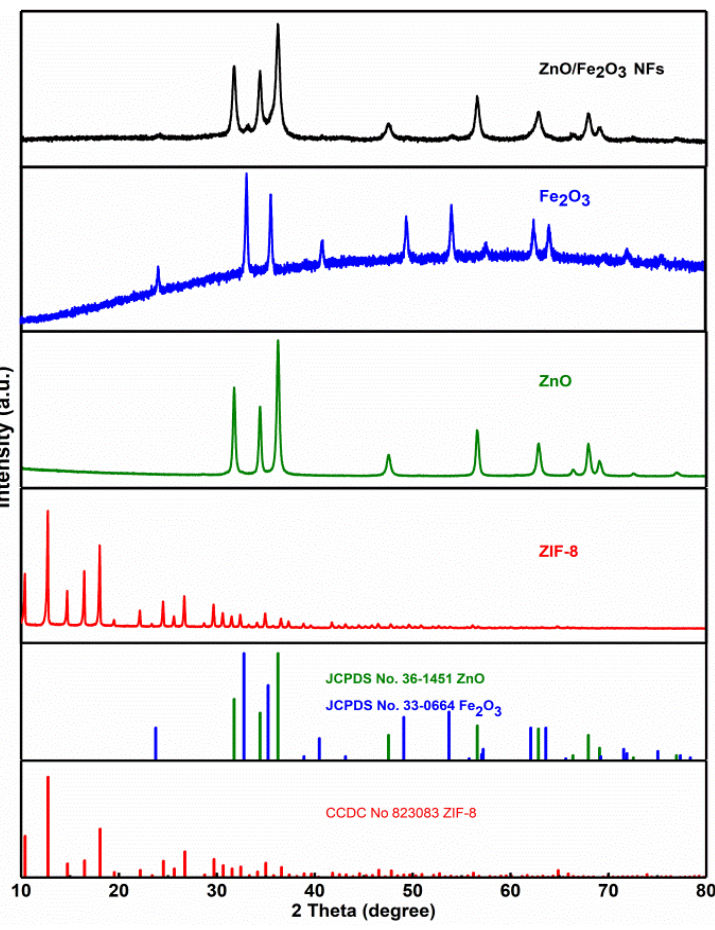
Figure 1. XRD patterns of the ZIF-8, ZnO, Fe 2 O 3 and ZnO/Fe 2 O 3 NFs as indicated.